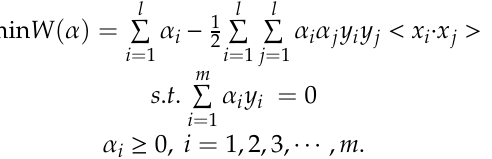
Table 1. Commonly used kernel functions.